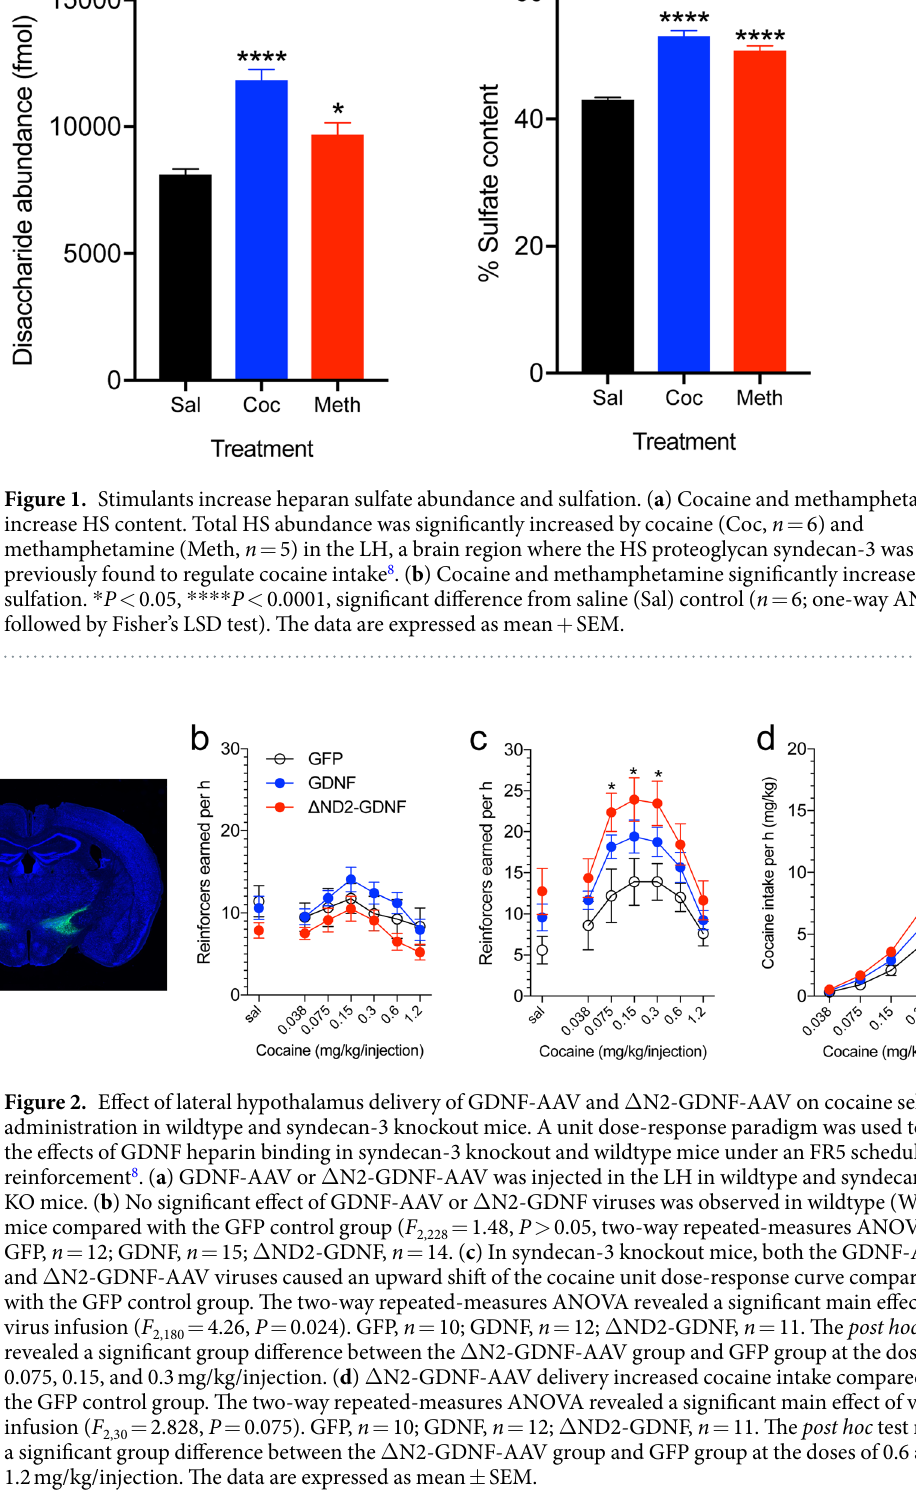
the AAV-mediated delivery of heparanase, the endoglycosidase that is responsible for degrading HS at glucu- ronidic bonds 17 at the cell-surface and in the extracellular matrix, resulting in remodeling of the extracellular matrix and the modulation of HS-dependent signaling 13 . As shown in Fig. 3, the AAV-mediated delivery of hep- aranase in the LH accelerated the acquisition of cocaine self-administration in both syndecan-3 knockout and